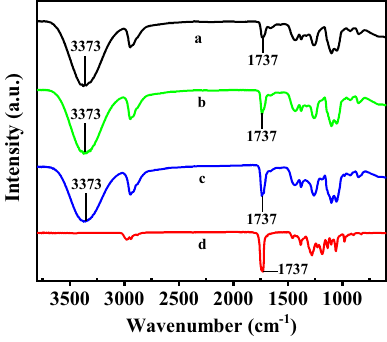
Figure 6: FTIR spectra of ( a ) PVA, ( b ) PVA/ ( P ( 3HB - co - 4HB ) ( PVA 90 wt% ) , ( c ) PVA/P ( 3HB - co - 4HB ) ( PVA 70wt% ) , and ( d ) P ( 3HB - co - 4HB ) .